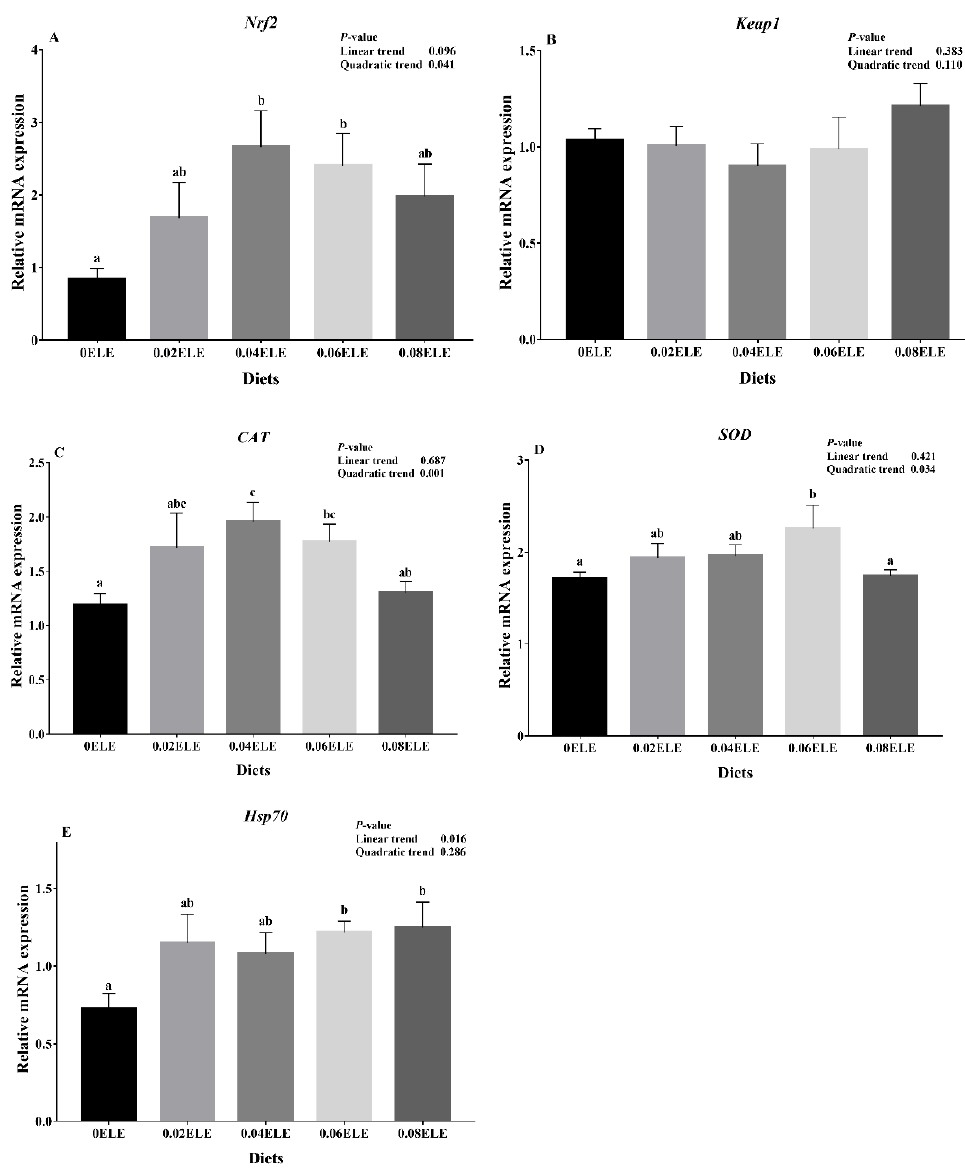
Figure 2. Relative expressions of Nrf2 signaling pathway and Hsp70 with different ELE levels. Nrf2 ( A ); Keap1 ( B ); CAT ( C ); SOD ( D ); Hsp70 ( E ). Data are expressed as means ± S.E.M., value with different letters (a, b, c) are significantly different ( p < 0.05).